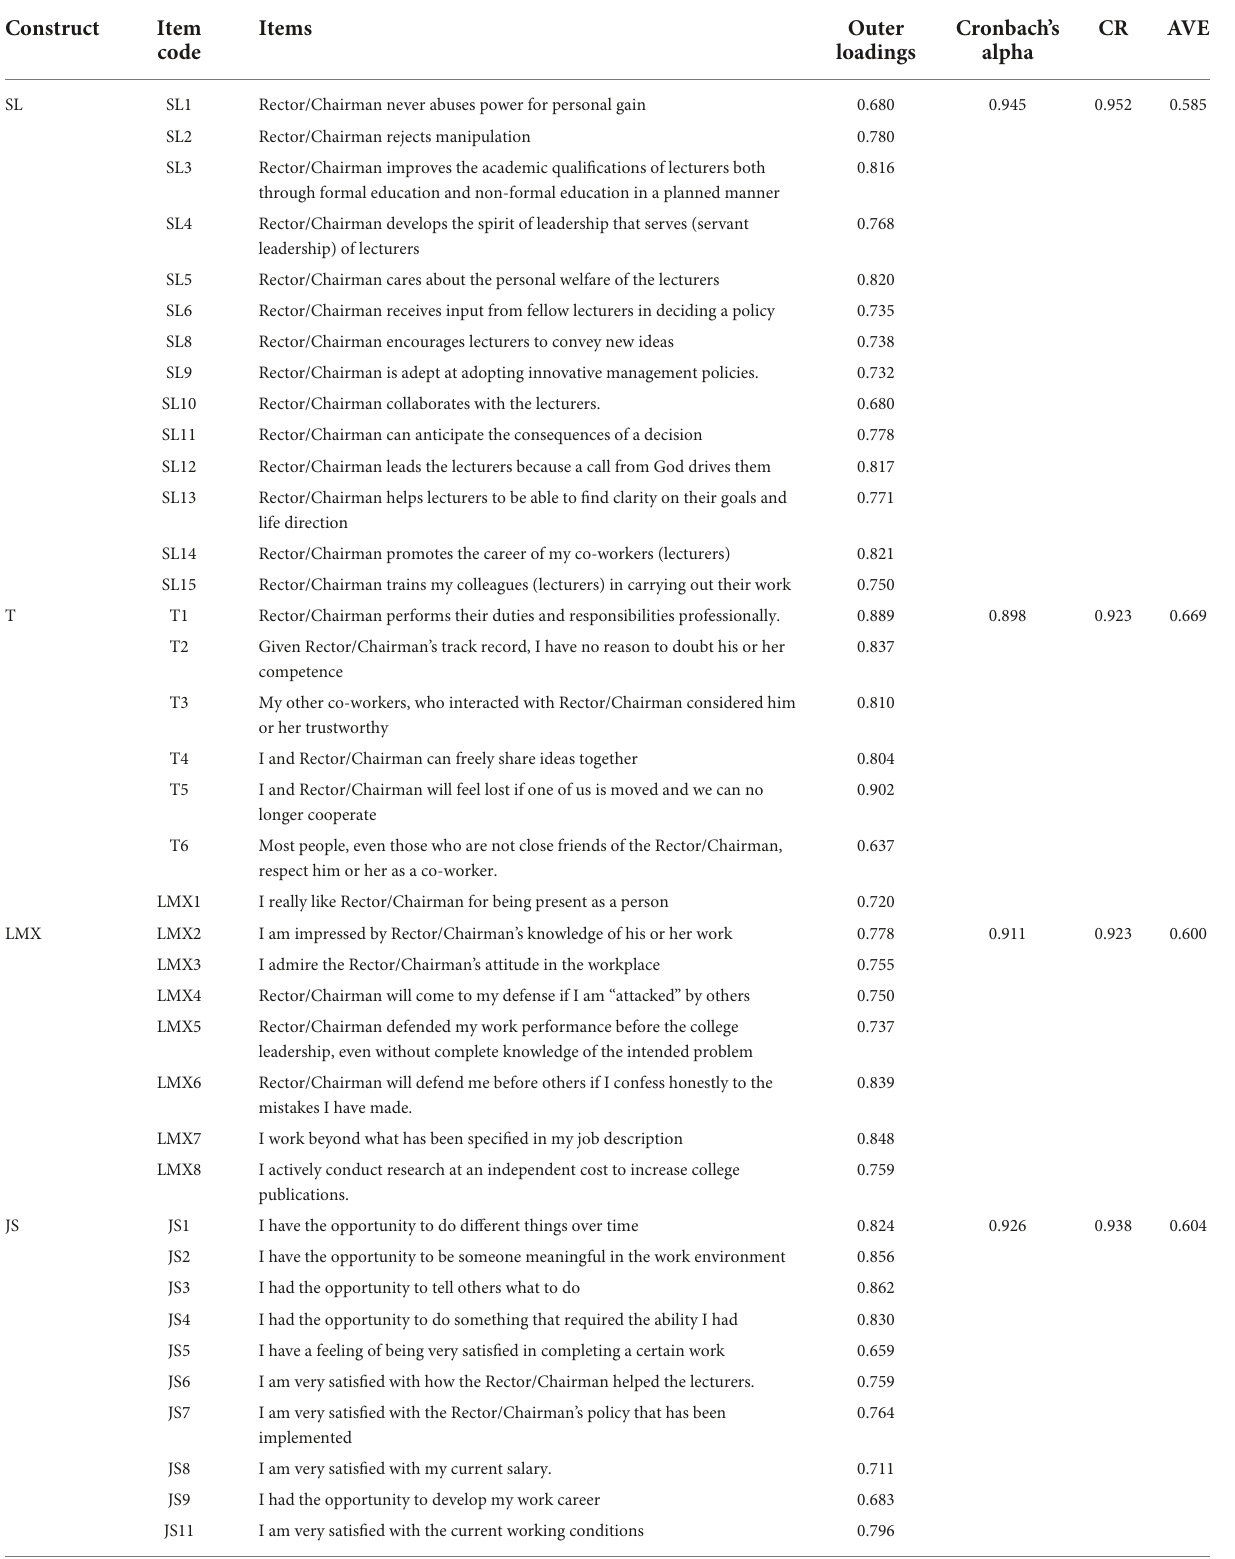
TABLE 4 Convergent validity and internal